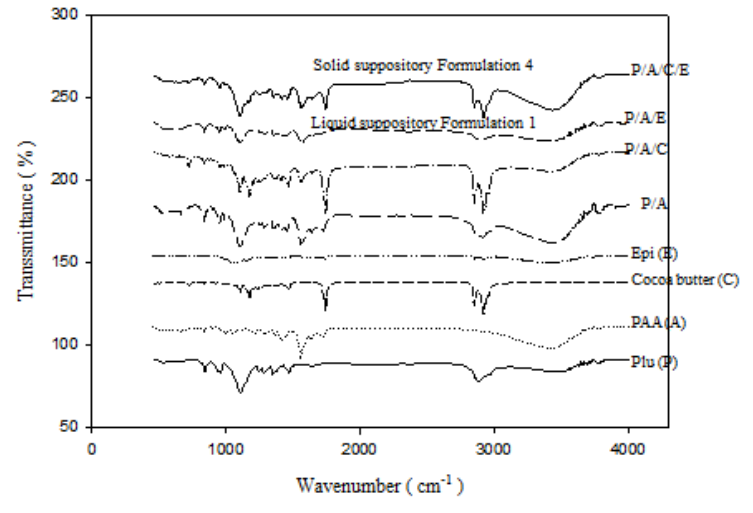
Figure 4. FTIR spectra of Plu (P), PAA (A), cocoa butter (C), and Epi (E), as well as Formulation 1 (P/A/E) and Formulation 4